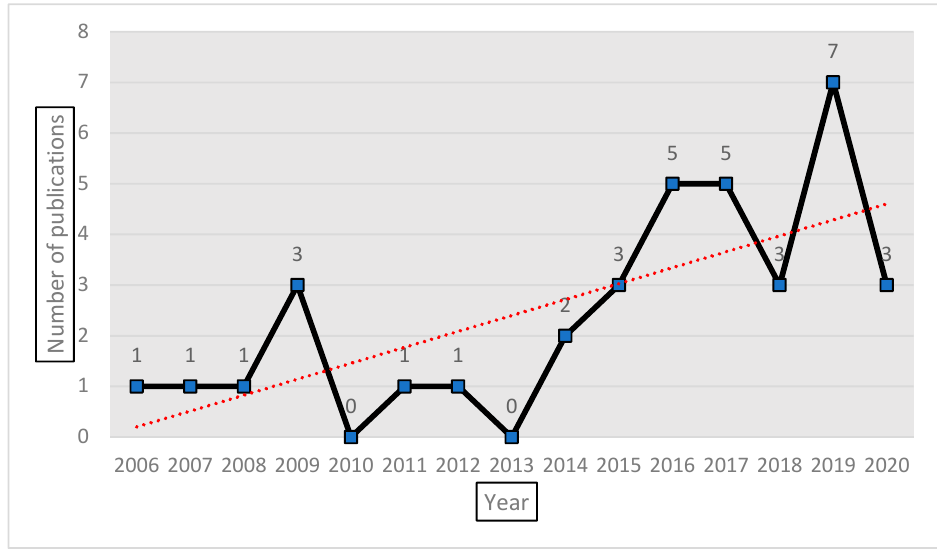
Figure 2. Distribution of papers based on year of publication.